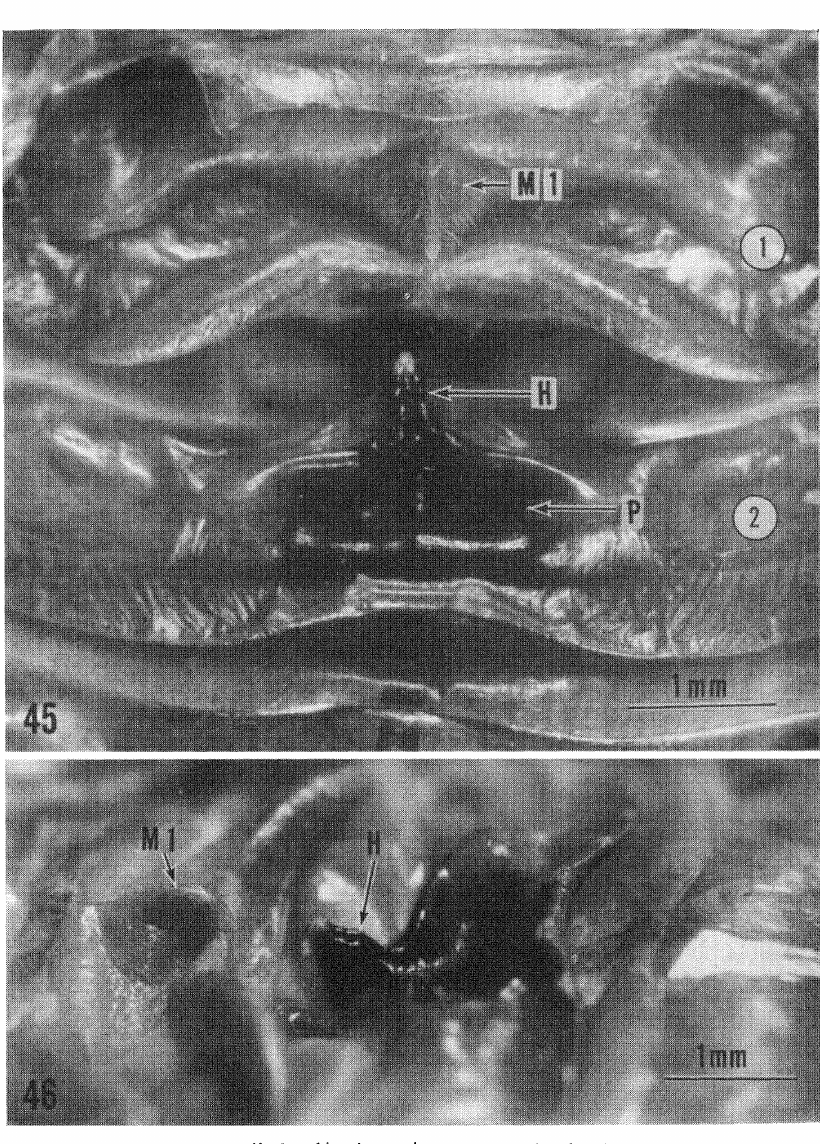
Figs. 45-46. Poeciloderrhs ferruginea. Tergal glands on segments and 2 (circled numbers). (166, USNM). St. Catharina, Nova Teut0nia, Brazil. Dorsal (Fig. 45) and lateral (Fig. 46) views. (det. Roth). M1 pyramidal shaped, setose mound on segment 1; H sclerotized horn on segment 2; P